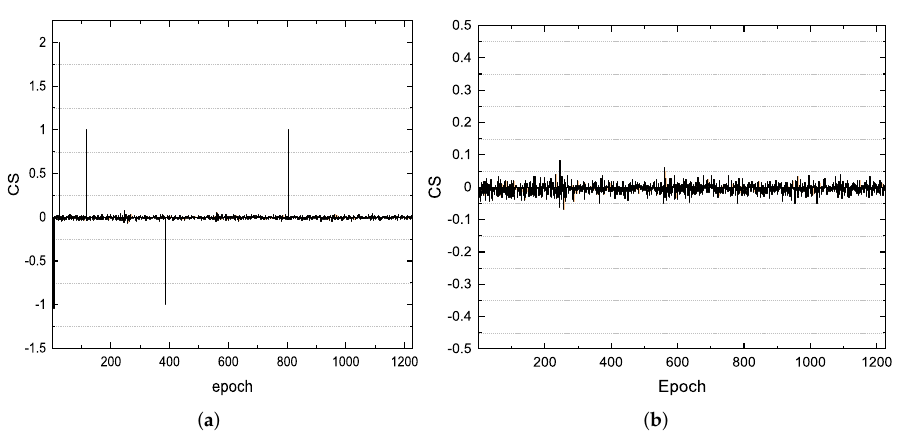
Figure 15. Cycle slip detection ( a ) and repair ( b